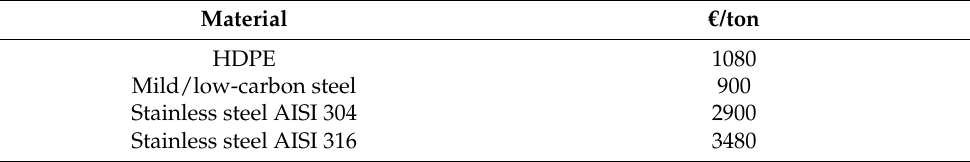
Table 1. Market price of reference materials (Source: Milano Finanza/Camera di Commercio di Milano. Average market price from the producer/importer to the industry, VAT